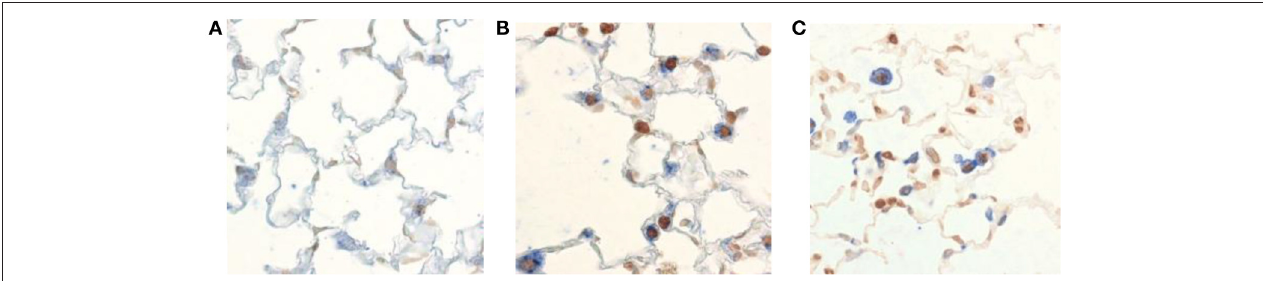
FIGURE 3 | Visualization of apoptotic cells in the lung of mice with COPD. TUNEL-staining demonstrates an increase in apoptotic cells (dark brown nuclei) in the lungs of mice exposed to cigarette smoke (B,C) compared to air-exposed animals (A) . This figure has been adapted from Demedts et al. (2006).